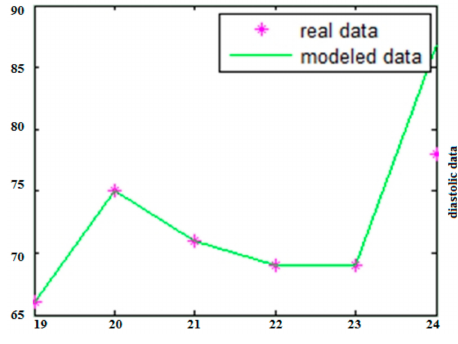
Figure 25. The trend of the diastolic